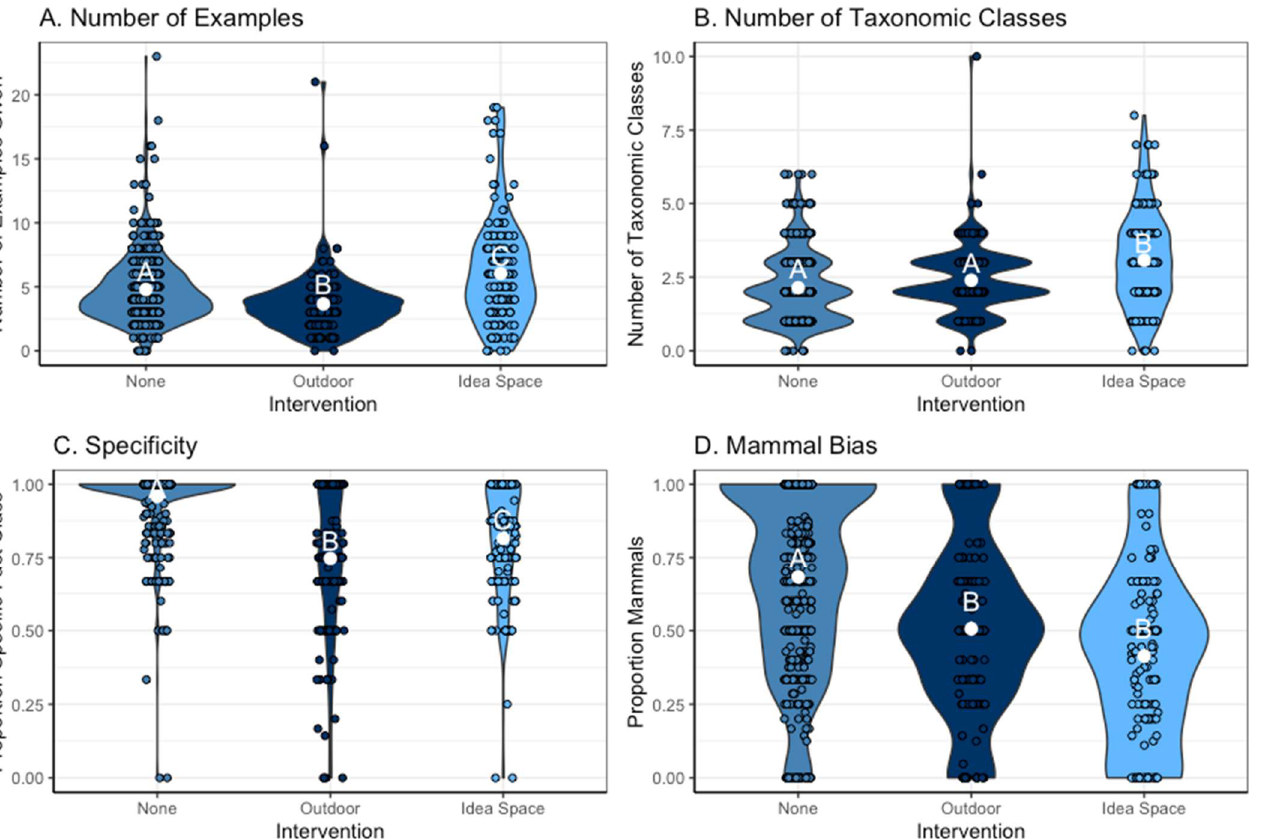
Figure 4. Violin plots visualizing comparisons between the three interventions, none, outdoor, and idea-space, and student responses, including ( A ) the number of examples given, ( B ) the number of taxonomic classes represented (breadth), ( C ) the specificity of the responses (proportion of examples given that were a specific past class), and ( D ) mammal bias (proportion of examples given that were mammals). Figures were made with raw data, and analyses presented in the text include student and question topic as random effects (n = 775). Students in the idea-space intervention generated more responses, with a greater number of taxonomic classes represented, and their responses were more specific and had a lower mammal bias compared to the no-intervention treatment. Letters on the graph denote significant differences using pairwise t -tests ( p < 0.05); raw data are shown as jittered points.